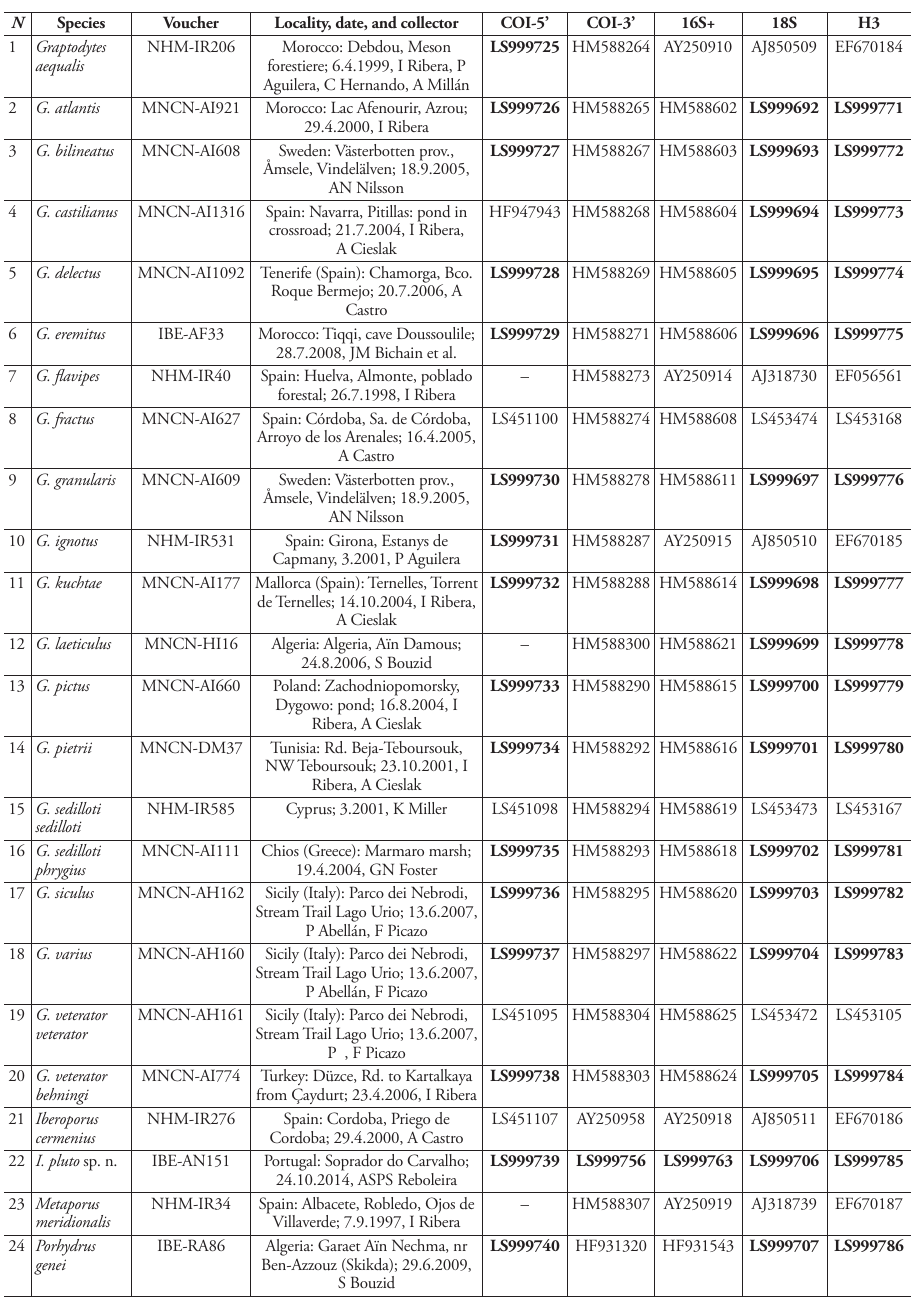
Table 1. Material used in the molecular phylogeny of the Siettitia group of genera, with locality, collec- tor, and EMBL accession numbers. Newly obtained sequences are in bold typeface. Nomenclature follows Nilsson and Hájek